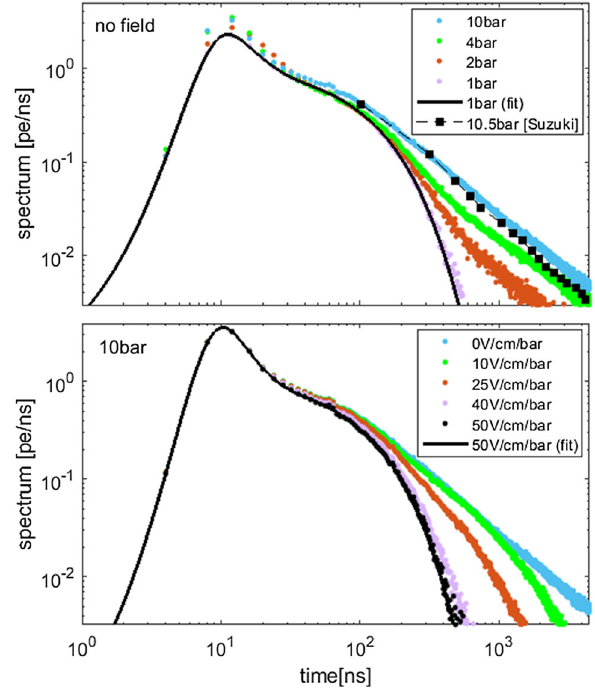
Fig. 11 Average time spectra for the primary scintillation signal (S1) from α -particles, as detected with the unfiltered PMs (range 145– 600 nm), given in photoelectrons per ns. Top: dependence with pres- sure for no-field conditions, with data from [21] given as squares. Bot- tom: dependence with pressure-reduced field at 10 bar. A fit to Eq. (4) (including a fast and slow component) is given by the continuous line, in recombination-free